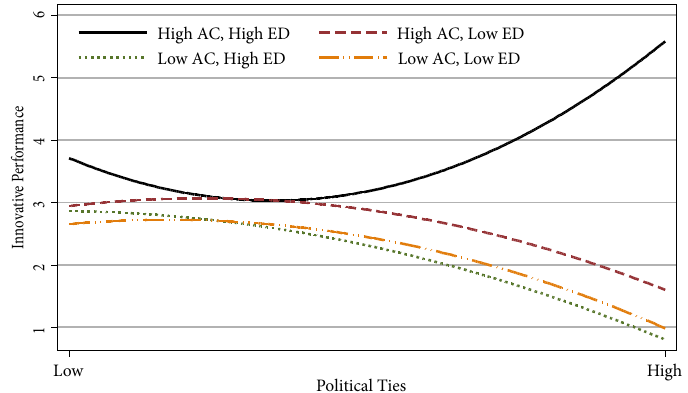
Figure 4. Curvilinear interaction of politic ties, absorptive capacity, and environmental dynamics on corporate innovation performance